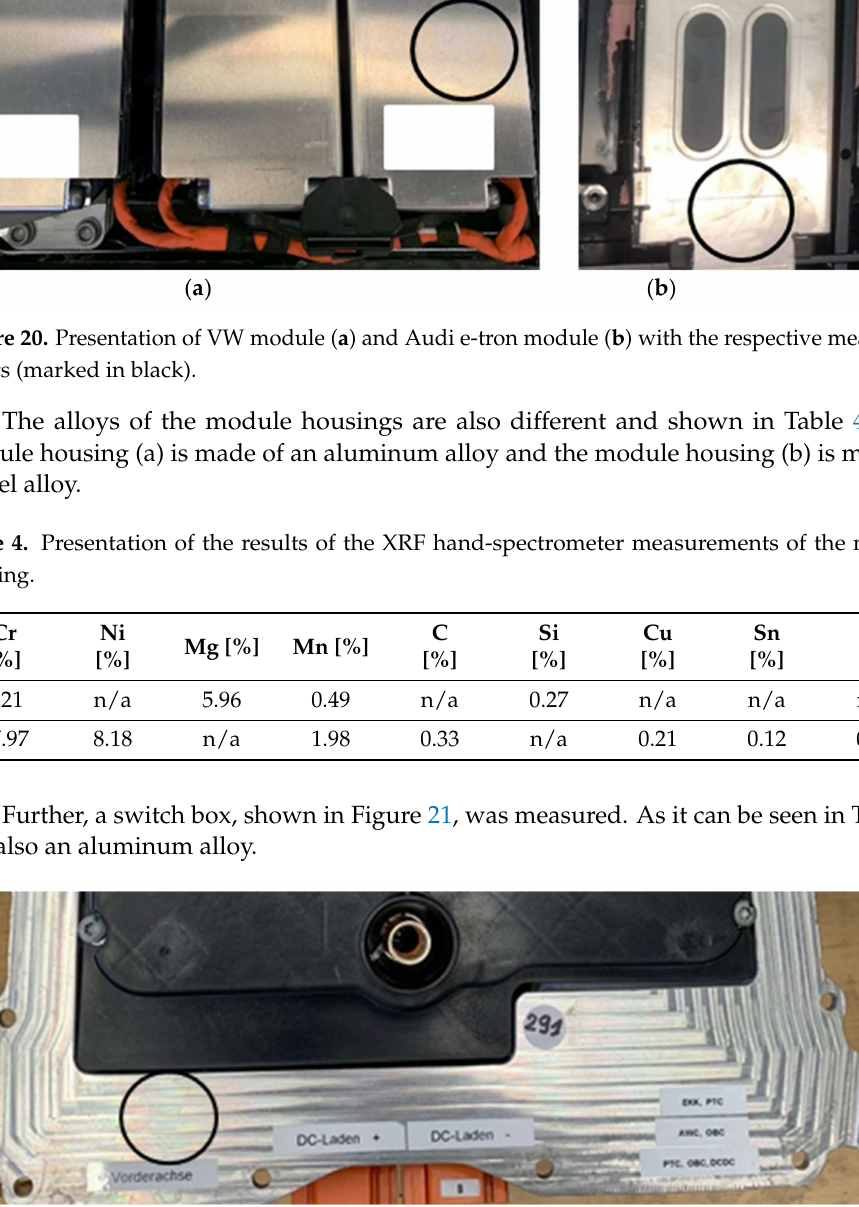
Figure 21. Presentation of the switch box and the black marked measuring points. Table 5. Presentation of the results of the XRF hand-spectrometer measurements of a switch box. Switch